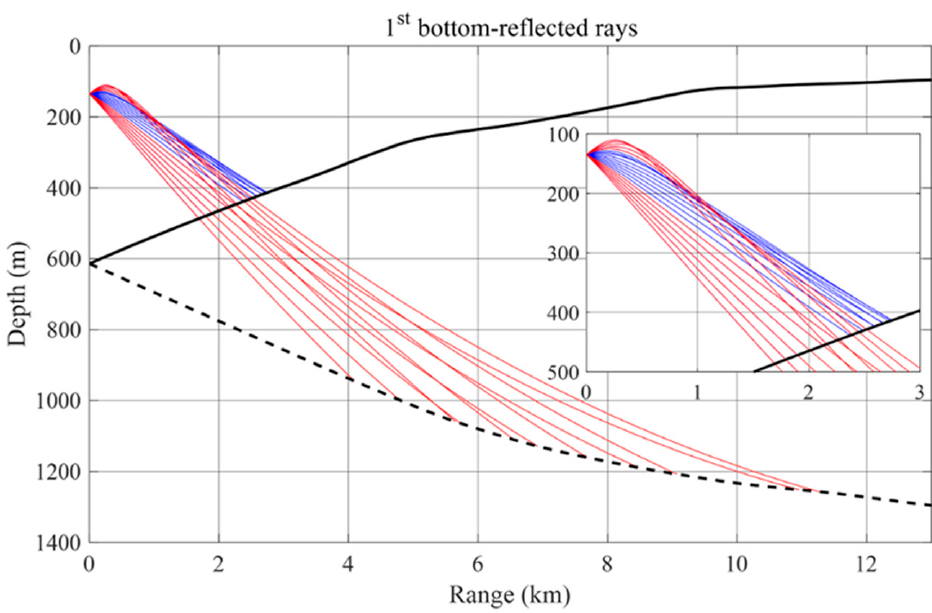
Figure 6. Ray tracing of first bottom-reflected rays in an ocean environment at both broadsides of the array for ping 97 (black solid line: the bathymetry at 90 ◦ (starboard), dashed black line: bathymetry at 270 ◦ (port)). Rays in blue do not hit the lower bathymetry and are refracted upwards.